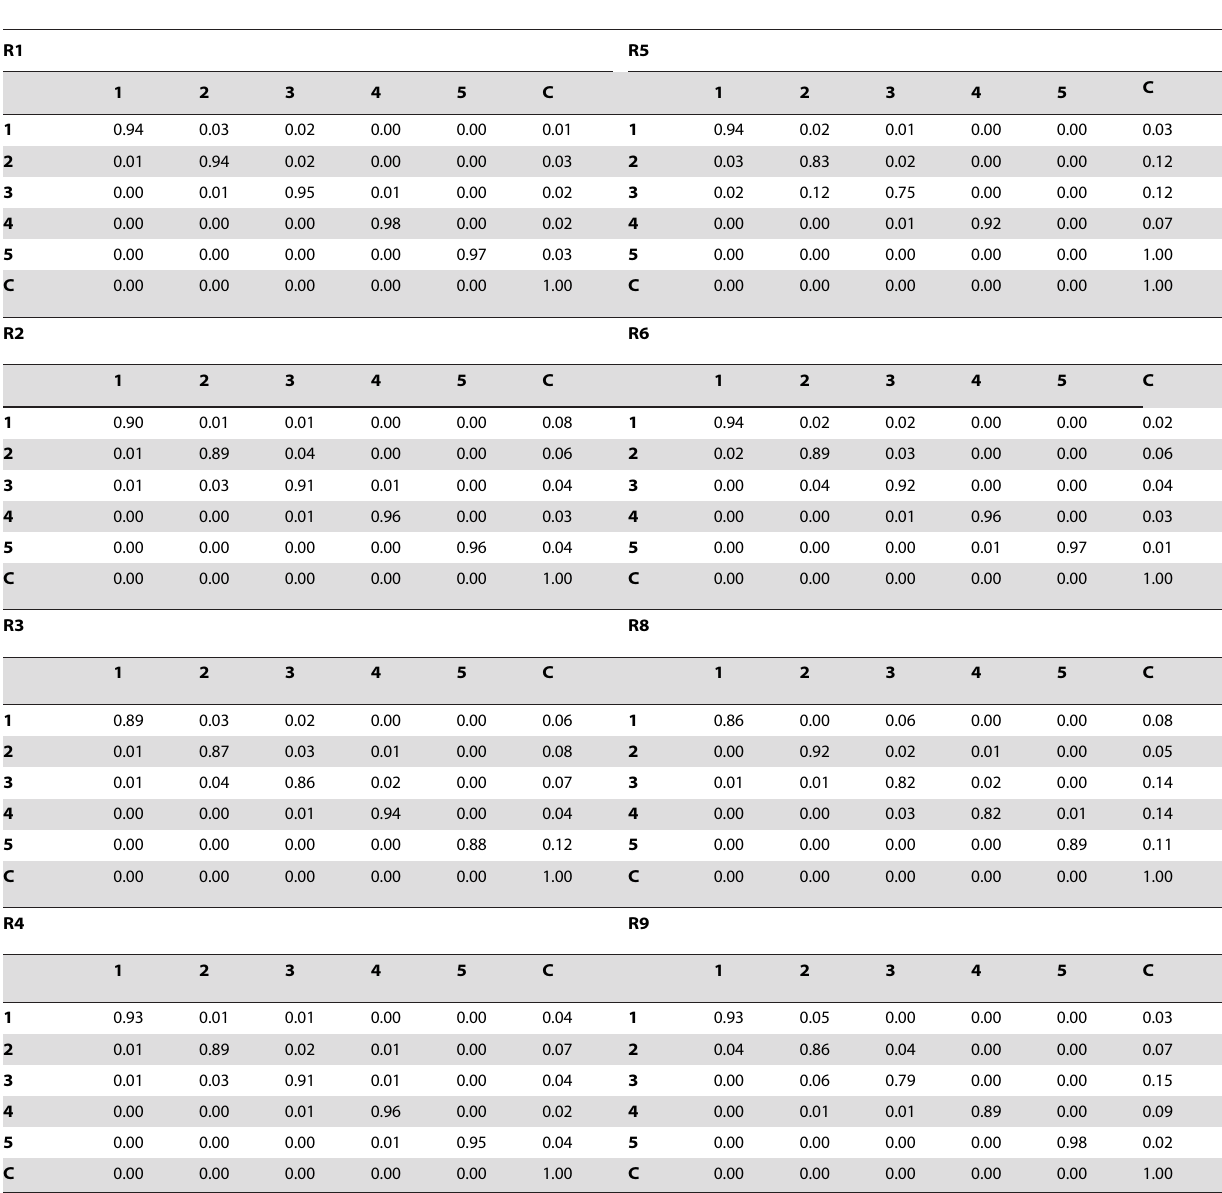
Table 4. Daily transition probabilities between incident complexity levels, sorted according to Forest Service Region.